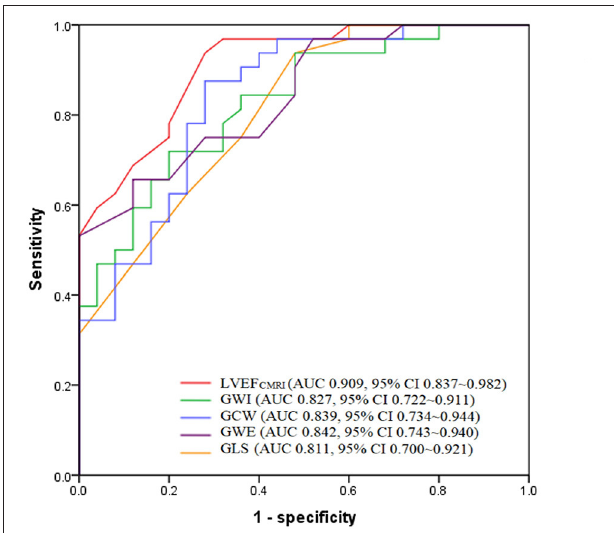
FIGURE 4 | Receiver operating characteristic analysis of LVEF CMRI , GWI, GCW, GWE, and GLS for predicting LV myocardial fibrosis. LVEF CMRI , cardiac magnetic resonance imaging-derived left ventricular ejection fraction; GWI, Global work index; GCW, Global constructive work; GWE, Global work efficiency; GLS, Global longitudinal